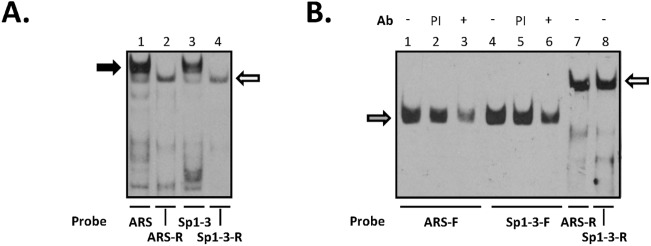
The AR 5’UTR possesses overlapping regulatory elements.Nuclear extract from DU145 cells were incubated with the labelled oligonucleotide probes indicated below each gel and the products resolved by electrophoretic mobility shift analysis. Additions are shown above the gels and were: Ab, antibody; PI, pre-immune serum. EMSAs are representative of at least 3 independent experiments. (A) Either double stranded probes or single stranded oligonucleotides of the reverse strand were incubated with nuclear extract and protein-DNA complexes resolved: black arrow indicates Sp1 and open arrow indicates pur-α binding respectively. (B) Forward and reverse single stranded labelled oligonucleotides of the regulatory elements were incubated with nuclear extract. Anti-hnRNP-K antibody was included where indicated and hnRNP-K-DNA complexes indicated by grey arrow and open arrow indicates pur-α binding.